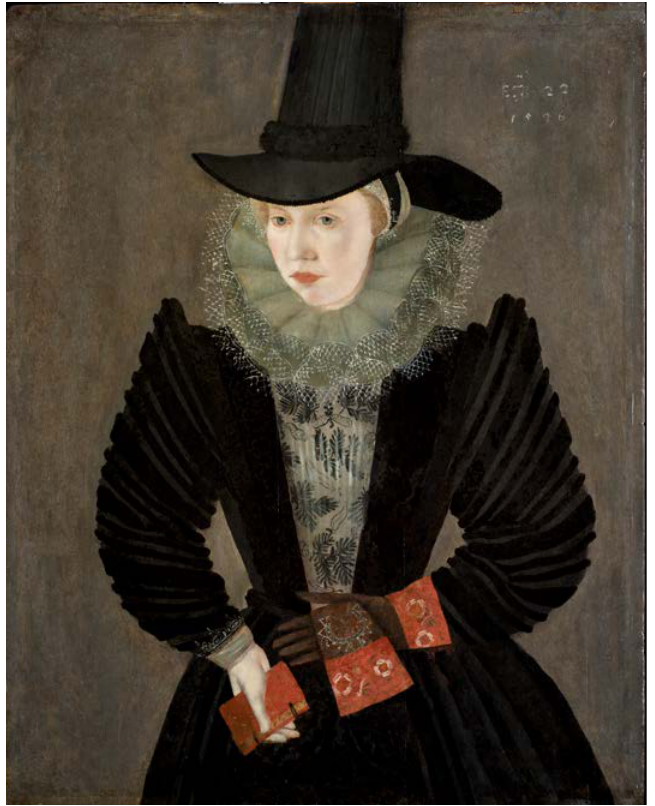
Figure 1 – Joan Alleyn , British School, oil on panel, 79.1 x 63.2 cm, 1596, DPG444. Courtesy of the Dulwich Picture Gallery,